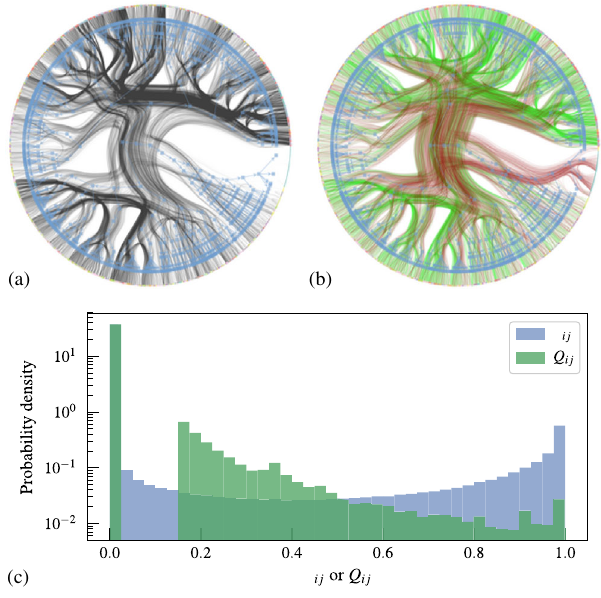
FIG. 16. (a) Inferred E. coli protein interaction network, according to uncertain data Q , using the MMP estimator from the posterior P ð A j Q Þ . (b) Difference between (a) and the MMP estimator using the original uncertainties Q directly, via P Q ð A j Q Þ [Eq. (65)]. Green edges are those that are added in (a), and red ones are removed. [The hierarchical partition is the same as in (a) and is shown only as a visual aid.] (c) Distribution of marginal posterior probabilities π ij and original uncertainties Q ij